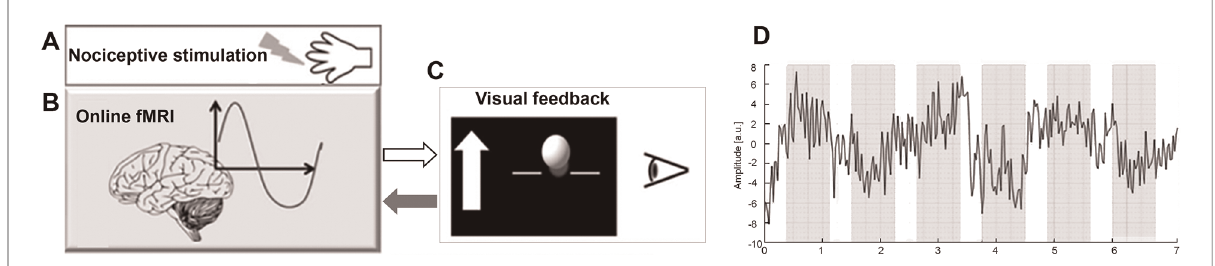
FIGURE 1 Schema of the fMRI neurofeedback setup. ( A ) Painful electrical stimuli were applied over the fourth digit of the right hand. ( B ) Online pre-processing and statistical analysis of the BOLD response were carried out from the target ROIs (rACC, pInsL) and a control ROI (UNR). ( C ) Differences in BOLD response between target ROIs and UNR ROI were computed and represented by a moving ball in front of a black background on a display screen. On the left side of the ball, a white arrow was displayed with the up or down directions depending on if the participants had to up- or down-regulate neural activity from the target ROIs. ( D ) Trend of a ROI time series in a trial of 7 min where the regulation (grey) and non-regulation (white) phases are